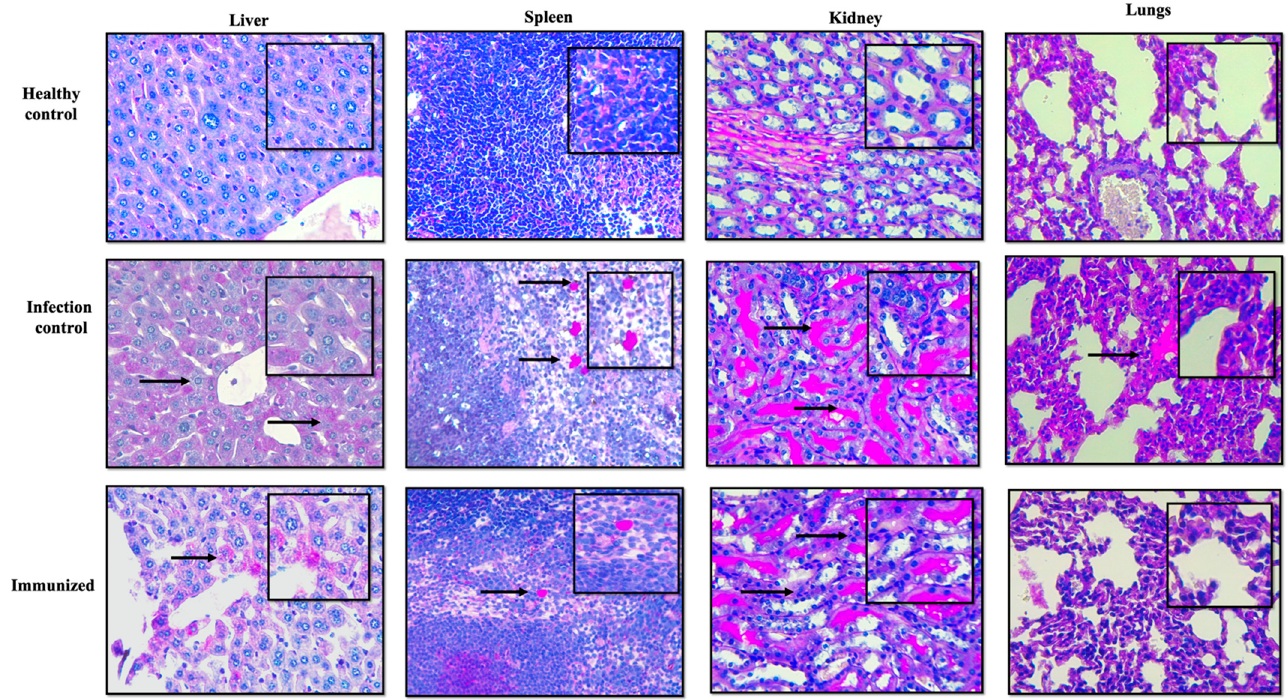
Figure 7. Comparative histopathology analysis of different tissue sections from immunized and C. glabrata -infected mice. Tissue sections recovered post infection were stained with PAS. The mouse from the infection control group displayed numerous abscesses with visible C. glabrata cells throughout the tissues, whereas secreted protein vaccinated mouse did not show any visible abscesses with a highly reduced fungal burden. The arrows indicate the presence of C. glabrata cells in the target tissues.